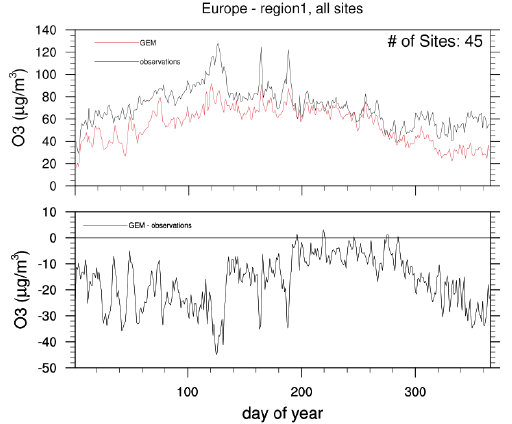
Figure 9. Time series of observed and modelled maximum 8h run- ning averaged ozone concentration averaged for all stations in west- ern Europe and MBE.